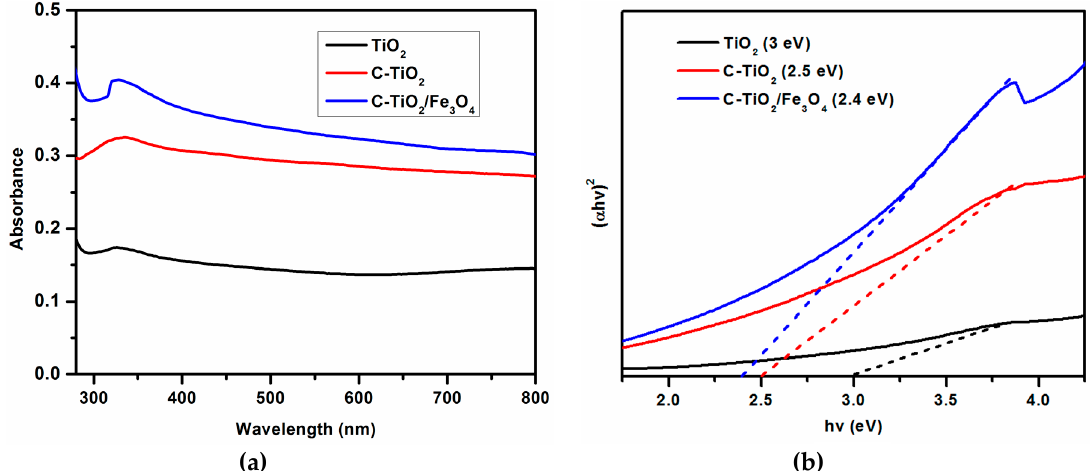
Figure 4. ( a ) UV-VIS diffuse reflectance spectra (DRS) of TiO 2 , C-TiO 2 , and C-TiO 2 / Fe 3 O 4 composite and ( b ) ( α hv)2 vs. hv curve of TiO 2 , C-TiO 2 , and C-TiO 2 / Fe 3 O 4 photocatalysts.